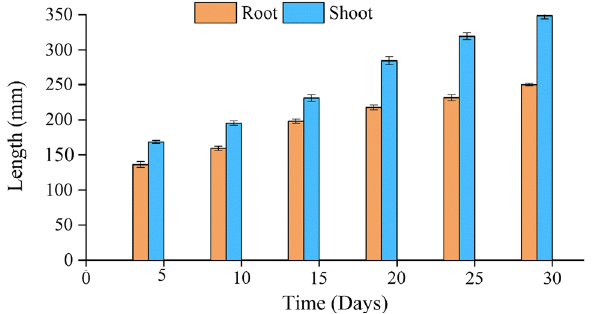
Fig. 4 Change in root and shoot length of ECP grown in